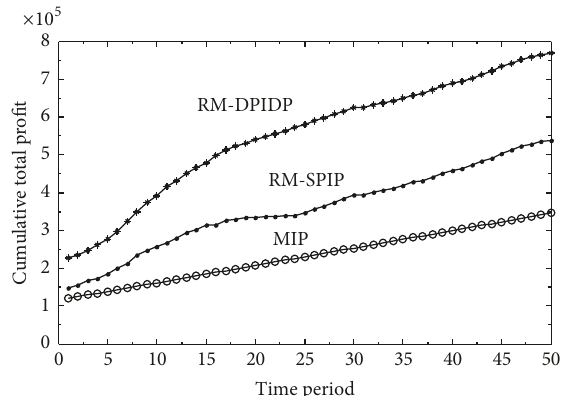
Figure 6: CPU time of 3 models for different length of planning